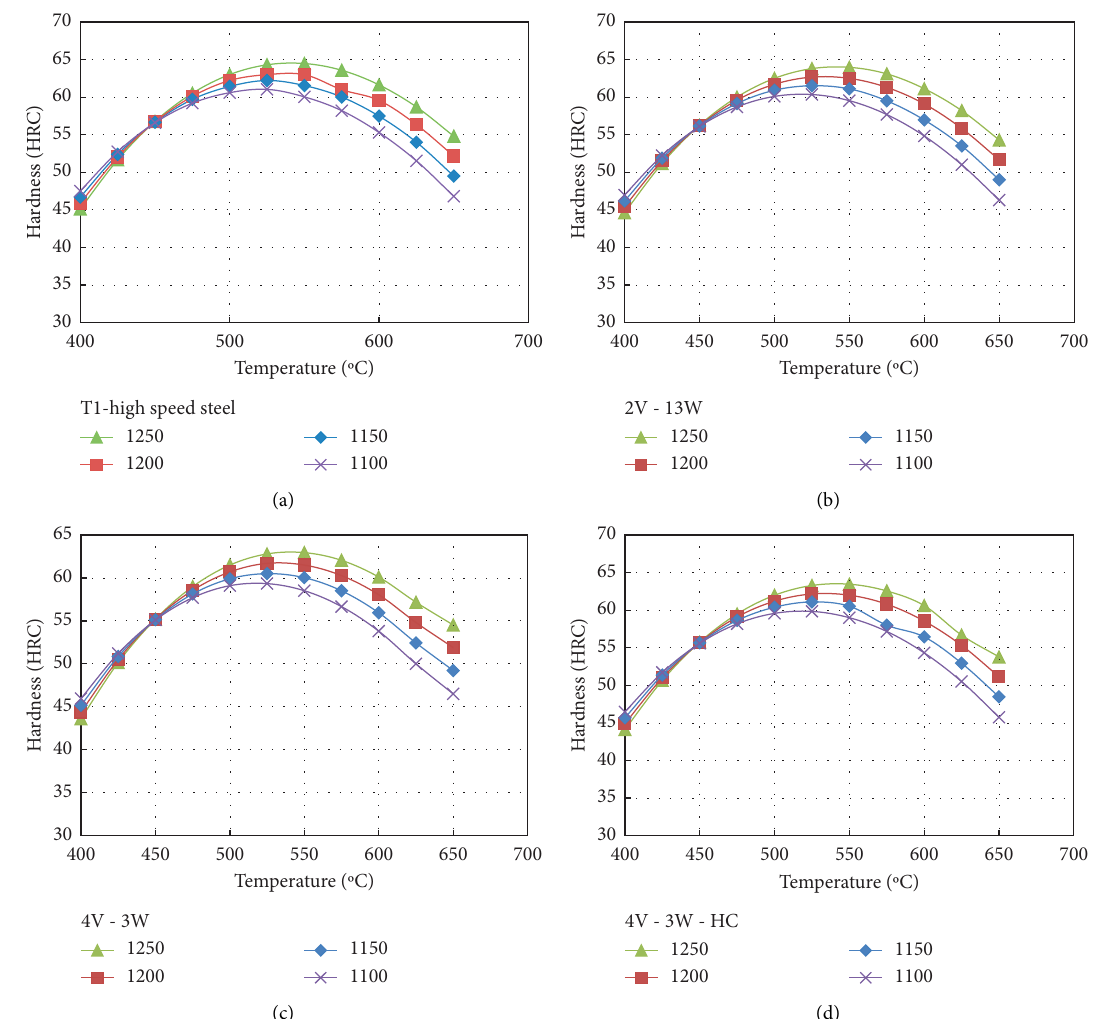
Figure 19: Hardness versus tempering temperature for investigating steel at diferent austenitization temperatures. (a) T1 high-speed steel, (b) 2V-13W, (c) 4V-3W, and (d) 4V-3W-HC.